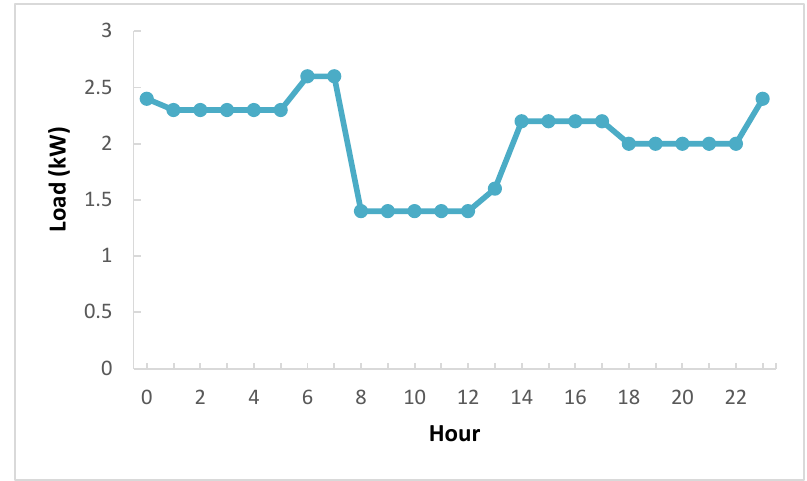
Figure 2. Hourly load profile for a summer weekday.